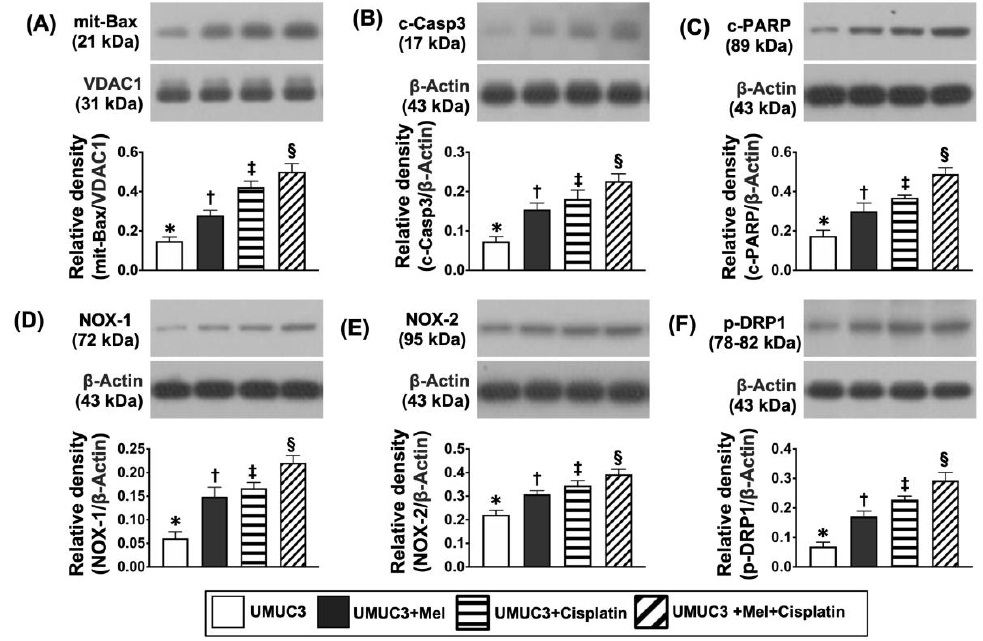
Figure 13 Figure 13. Protein levels of oxidative stress/mitochondrial damage apoptotic markers on day 28 after UMUC3 embedded into nude mouse back. ( A ) Protein level of mit-Bax, * vs. different symbols (†, ‡, and §), p < 0.0001. ( B ) Protein level of c-caspase 3 (c-Casp3), * vs. different symbols (†, ‡, and §), p < 0.0001. ( C ) Protein level of c-PARP, * vs. different symbols (†, ‡, and §), p < 0.0001. ( D ) Protein level of NOX-1, * vs. different symbols (†, ‡, and §), p < 0.0001. ( E ) Protein level of NOX-2, * vs. different symbols (†, ‡, and §), p < 0.0001. ( F ) Protein level of p-DRP1, * vs. different symbols (†, ‡, and §), p < 0.0001. n = 6 for each group. Mel =